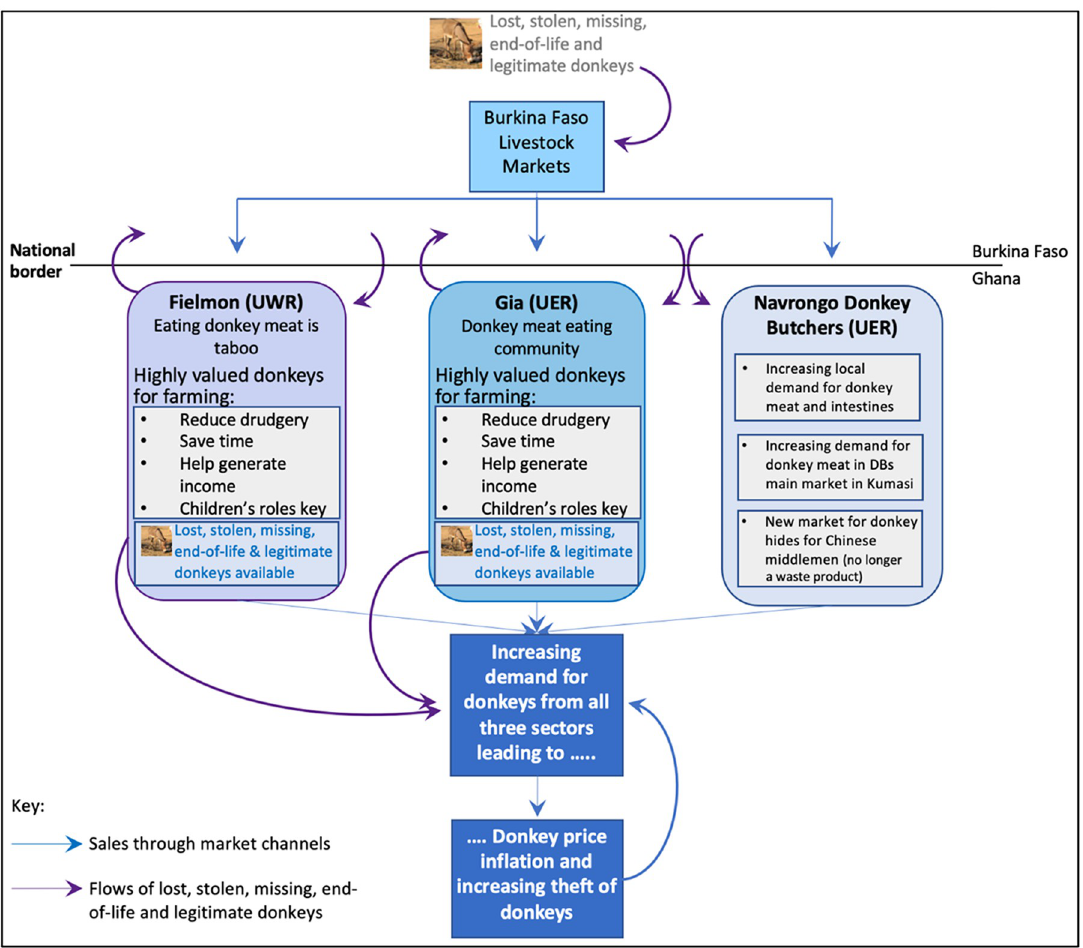
Fig 12. Overview of demand and price/value cycle of donkeys in northern Ghana. Donkeys may go missing and get lost or stolen from their original home; they may be stolen directly or may be sold at livestock markets by their original owner for various legitimate reasons including being at the end of their productive life. Source: Maggs, 2022